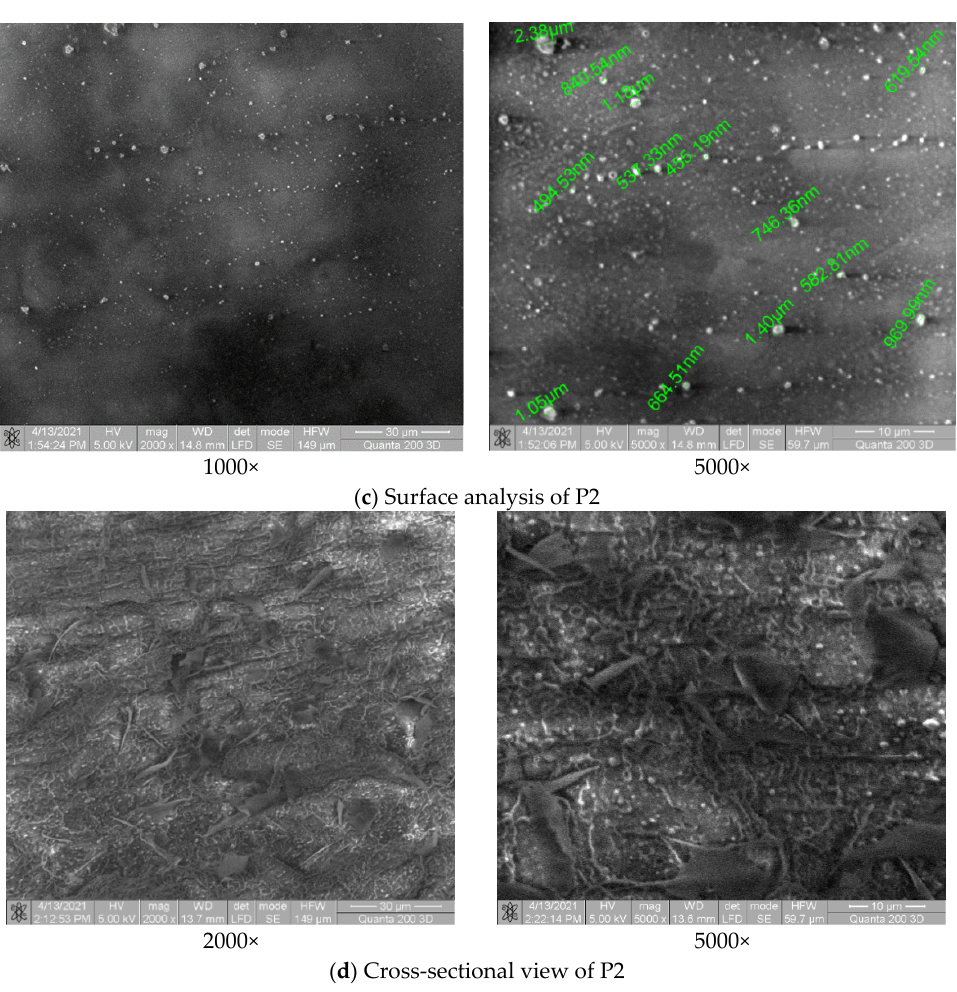
Figure 8. SEM analysis of the samples. ( a ) Surface analysis of P1; ( b ) Cross-sectional view of P1; ( c ) Surface analysis of P2; ( d ) Cross-sectional view of P2